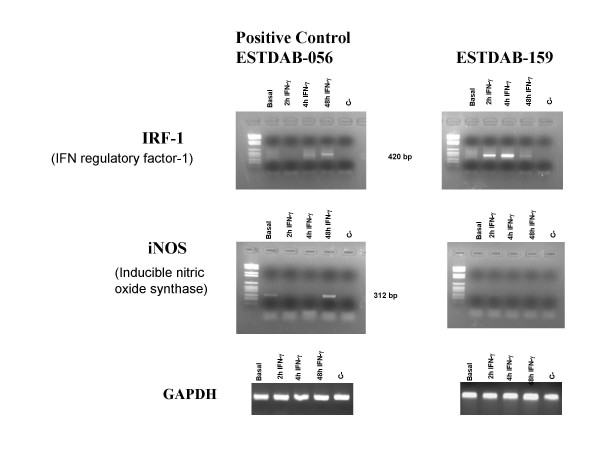
Time course effect of IFN-γ on the expression of IRF-1 and iNOS (A). Total RNAs were isolated from ESTDAB-159 cell line and form the control cell line ESTDAB-056 grown in the presence or absence of 800 U/ml IFN-γ for the indicated periods of time and analyzed for the relative levels of mRNA by RT-PCR.